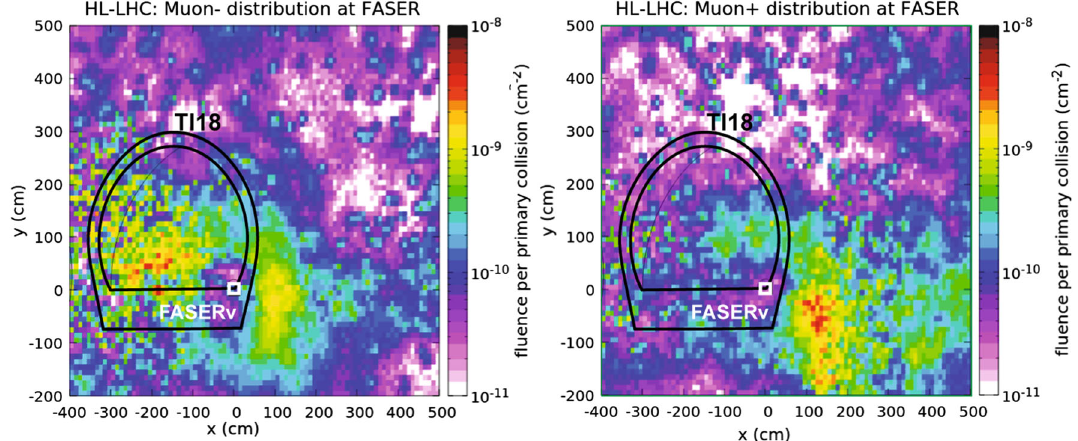
Fig. 14 Distributions of negative (left) and positive (right) muons crossing the tunnel TI18, which is in a symmetric position on the oppo- site side of the ATLAS IP with respect to FASER ν . The position of